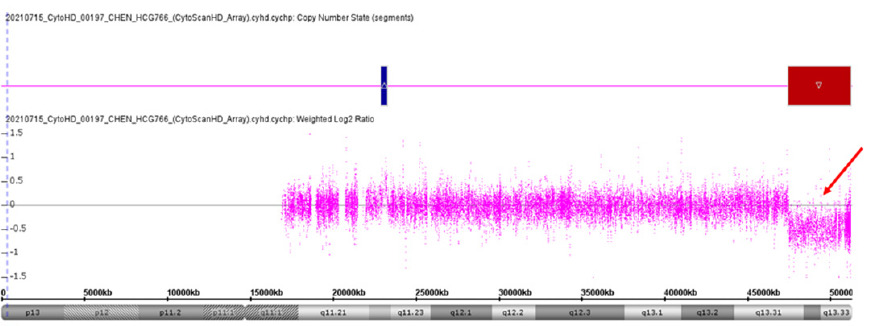
Figure 2. CMA revealed a 3.7 Mb microdeletion at 22q13.3 (red arrow) in the younger sister in this family. Table 1. List of genes deleted in the region of this microdeletion.